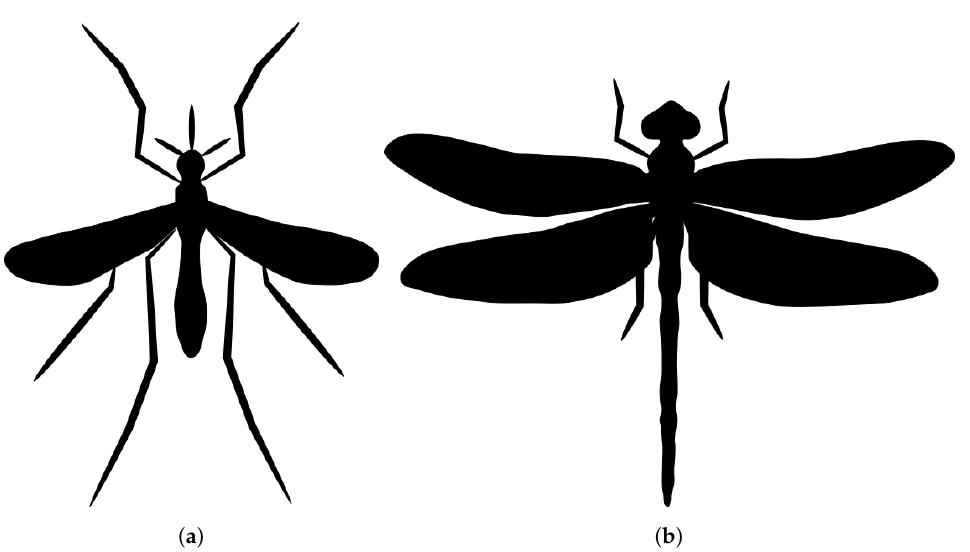
Figure 1. Comparison of a mosquito to a dragonfly: ( a ) Outline of a Culex mosquito— Culex quinque- fasciatus . ( b ) Outline of an Australian Emerald dragonfly— Hemicordulia australiae .